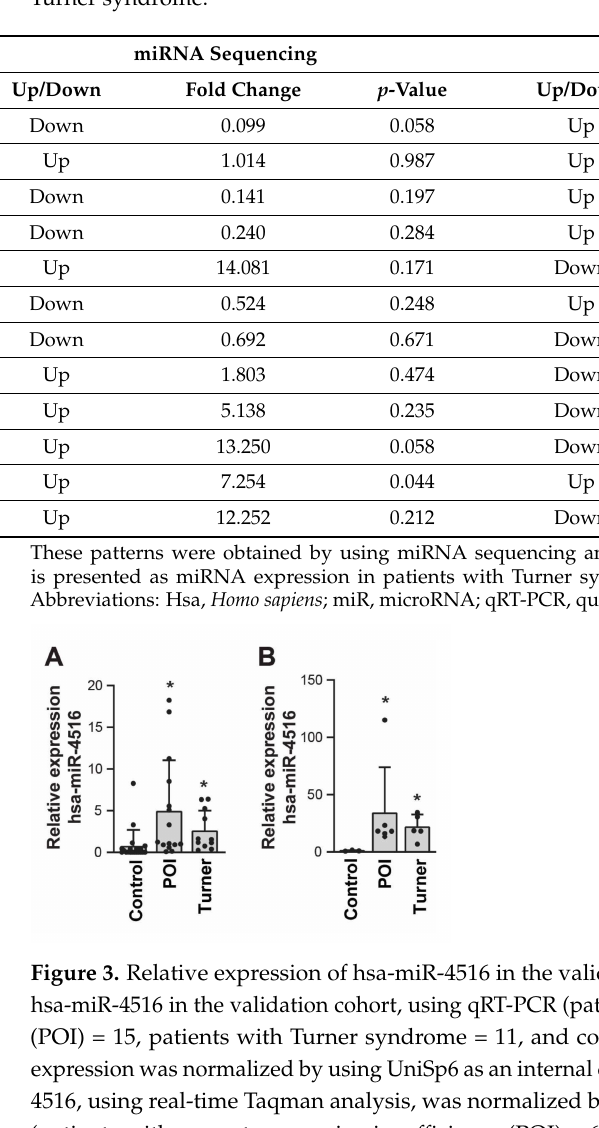
Table 7. Comparison of the relative expression patterns of selected microRNAs in patients with Turner syndrome.